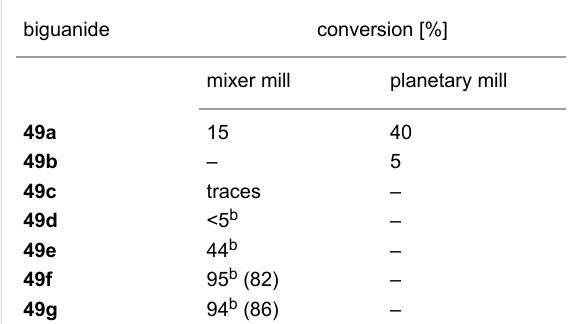
Table 1: The efficiency of mixer and planetary ball milling in the syn- thesis of biguanides 49a–g .